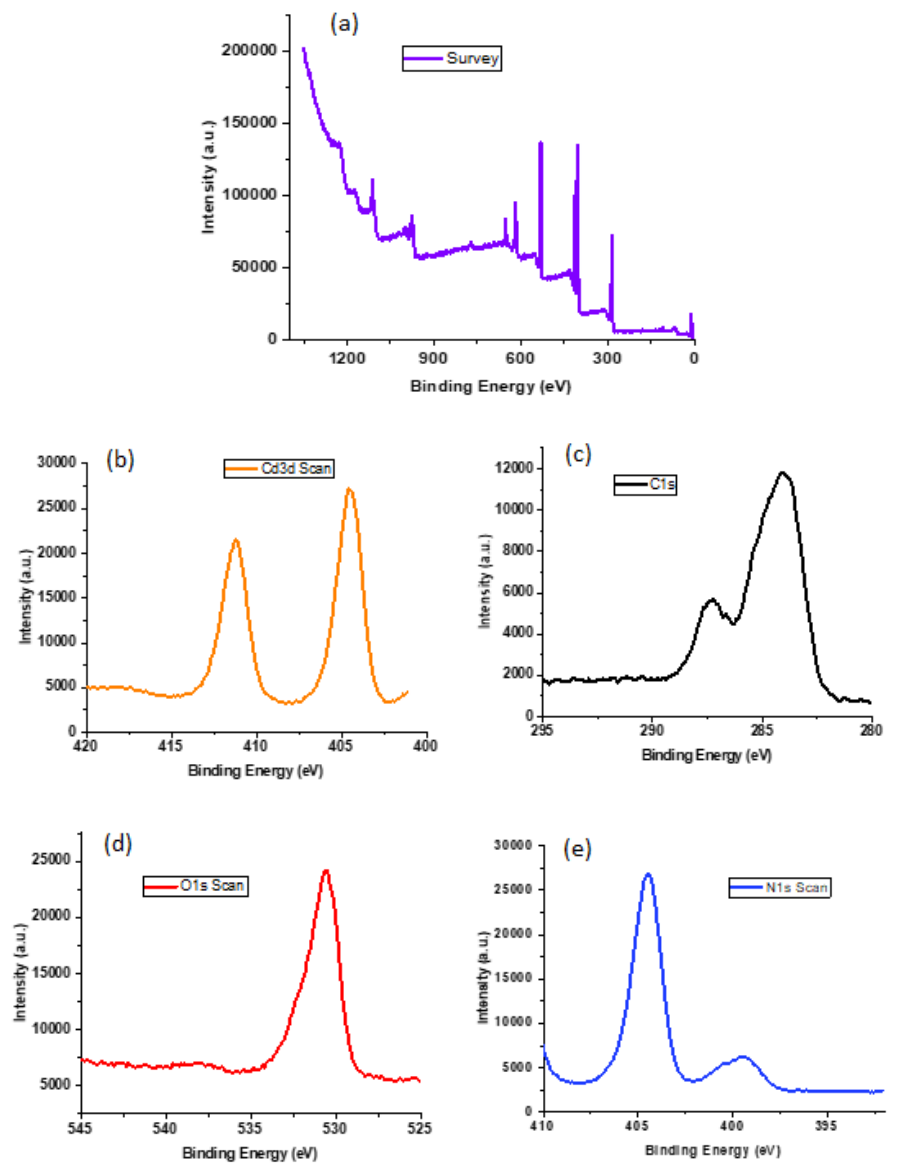
Figure 11. XPS analysis of CdMOF ( a ) Survey, ( b ) Cd 3d ( c ) C 1s, ( d ) O 1s, and ( e ) N 1s region. The thermal stability of CdMOF was studied by thermogravimetric analysis. CdMOF followed a multistage thermal degradation pattern, as shown in Figure 12. At around 200 °C, the initial weight loss (<10%) is associated with the loss of solvent molecules. The structural framework remained stable till 230 °C. The two decomposition steps, between 400 – 550 °C, result in the collapses (>60 wt.%) of the main structure to organic volatiles. Hence, the structure of CdMOF remains intact till 200 °C, and the thermally stimulated fragmentation of the bridging organic linkers took place above this temperature, resulting in the breakdown of the main MOF structure. The TGA and DTG are shown in Figure 12. The remaining material (12.8%) is expected to be a metal oxide.